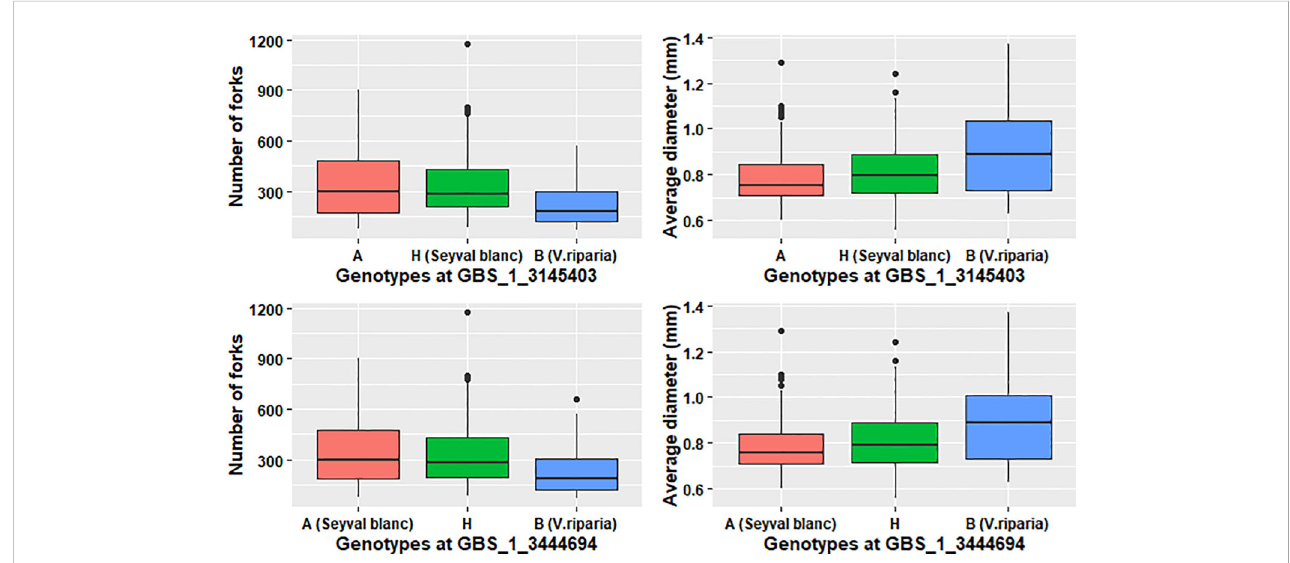
FIGURE 6 Genotype effect for markers surrounding LATERAL ORGAN BOUNDARIES DOMAIN candidate genes. The grandparent genotype is indicated in